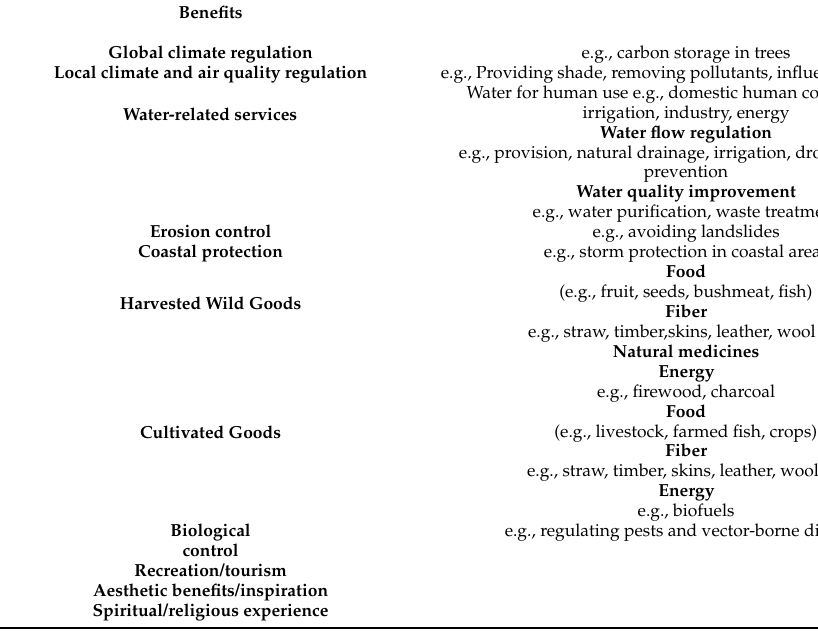
Table A2. The questionnaire table which was used to determine the most important ES in the study